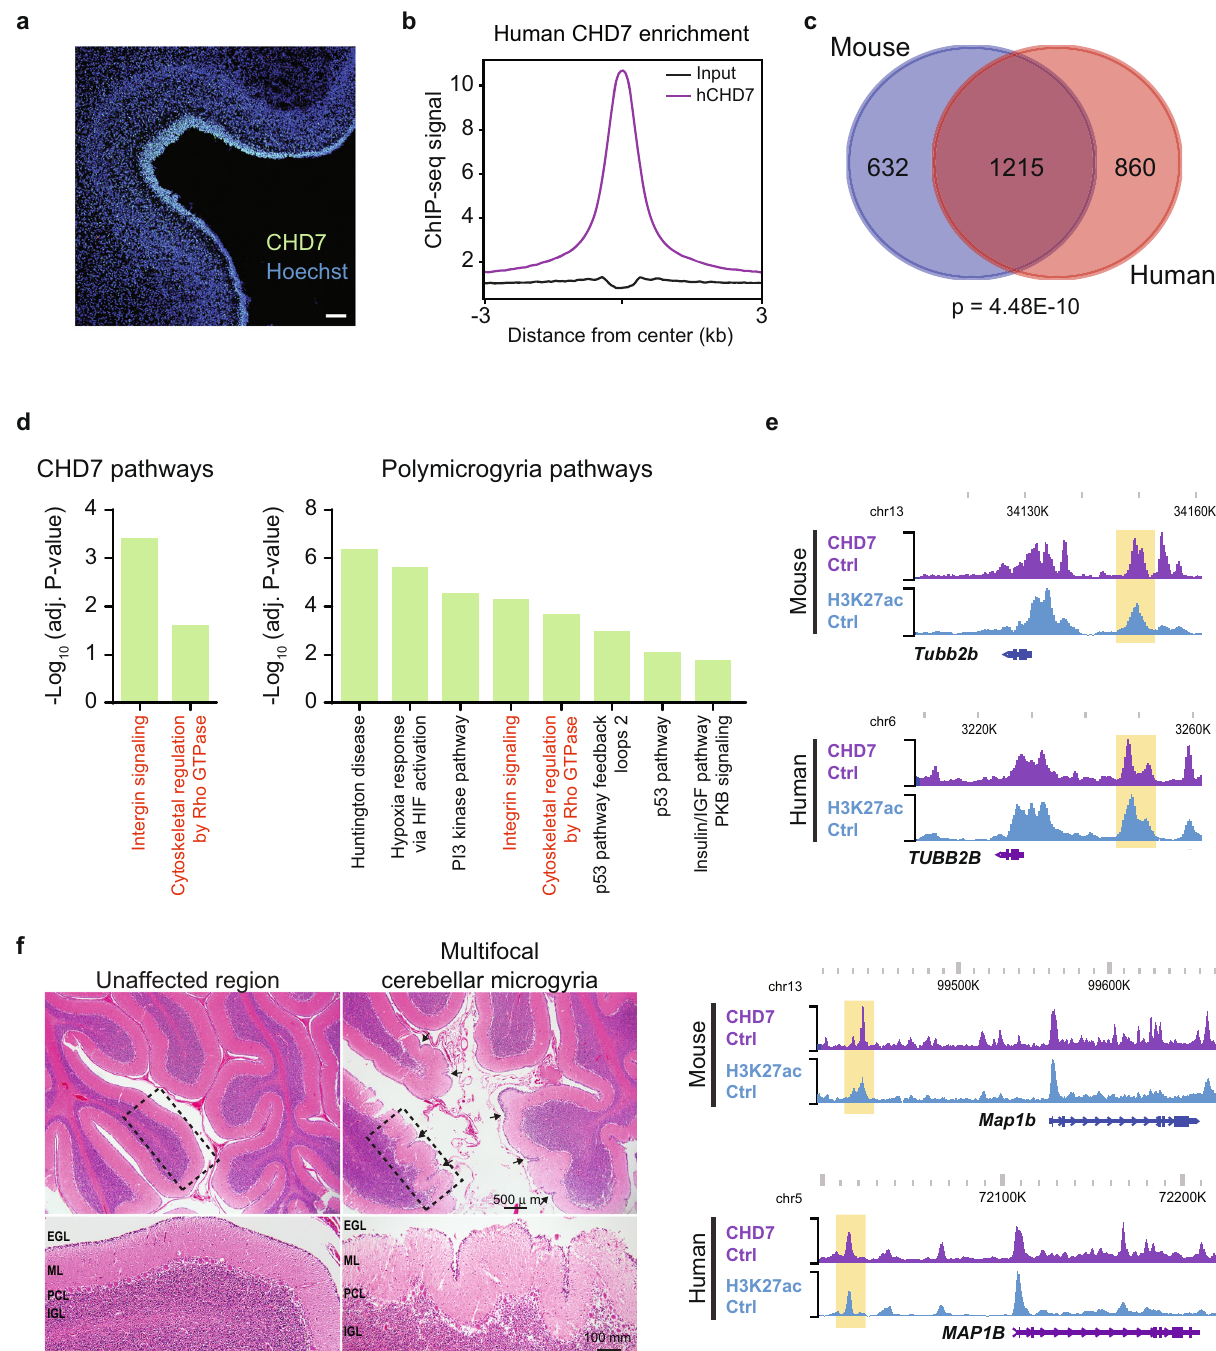
Fig. 6 CHD7-bound genes implicated in brain folding disorders are signi fi cantly conserved between perinatal mouse and fetal human cerebellum. a Immunohistochemistry analysis of 22 gestational week human cerebellum with antibodies recognizing hCHD7. Experiment was performed once on multiple sections. Scale bar: 100 µ m. b Aggregate plot of ChIP-seq signal for hCHD7 (purple) and input (black) centered on hCHD7 genomic binding sites ( n = 17,100). 22 gestational week anterior human cerebellum ( n = 1 for CHD7 Ctrl, n = 1 for input). c Venn-diagram showing overlap of CHD7 mouse and human target genes with hypergeometric analysis. p -value = 4.48E-10, hypergeometric. See Methods section for more details on analysis. d Panther pathways analysis of mouse CHD7 direct target genes (left) and PMG-associated genes (right). Shared pathways are shown in red. e WashU Epigenome Browser view of two CHD7 direct target genes (TUBB2B, top; MAP1B, bottom) found in mouse and human cerebellum. Each site shows ChIP-seq coverage of CHD7 and H3K27ac. f H&E staining of 5-month-old clinically diagnosed CHARGE syndrome patient. Arrowheads point to sites or excessive ectopic cerebellar foliation. Zoom in of dashed rectangle shown below. EGL external granule layer; ML molecular layer; PCL Purkinje cell layer; IGL internal granule layer. Experiment was performed once on multiple sections for each region. Please refer to Methods for additional details regarding patient cerebellar